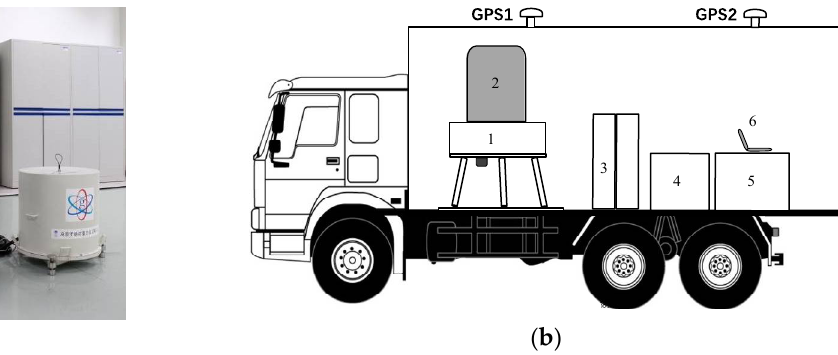
Figure 1. The truck-borne system based on CAG for measuring absolute gravity in the field: ( a ) The apparatus of CAG; ( b ) The truck-borne system includes: 1. three-axis leveling platform and the passive vibration isolation platform; 2. the vacuum sensor system; 3. UPS; 4. optical system; 5. control system; 6. computer.